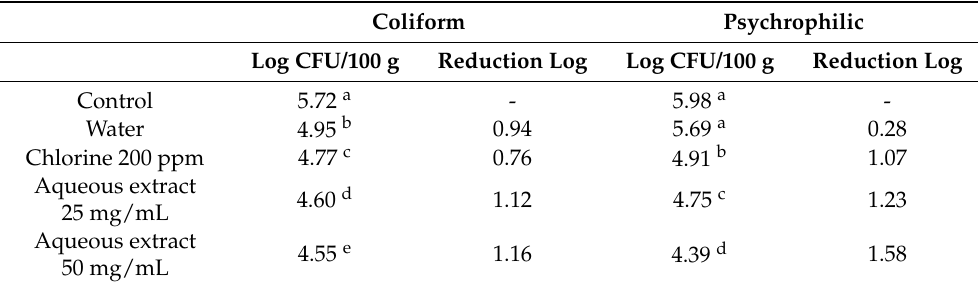
Table 3. Effect of aqueous extract on total counts of coliform and psychrophilic bacteria of treated alfalfa